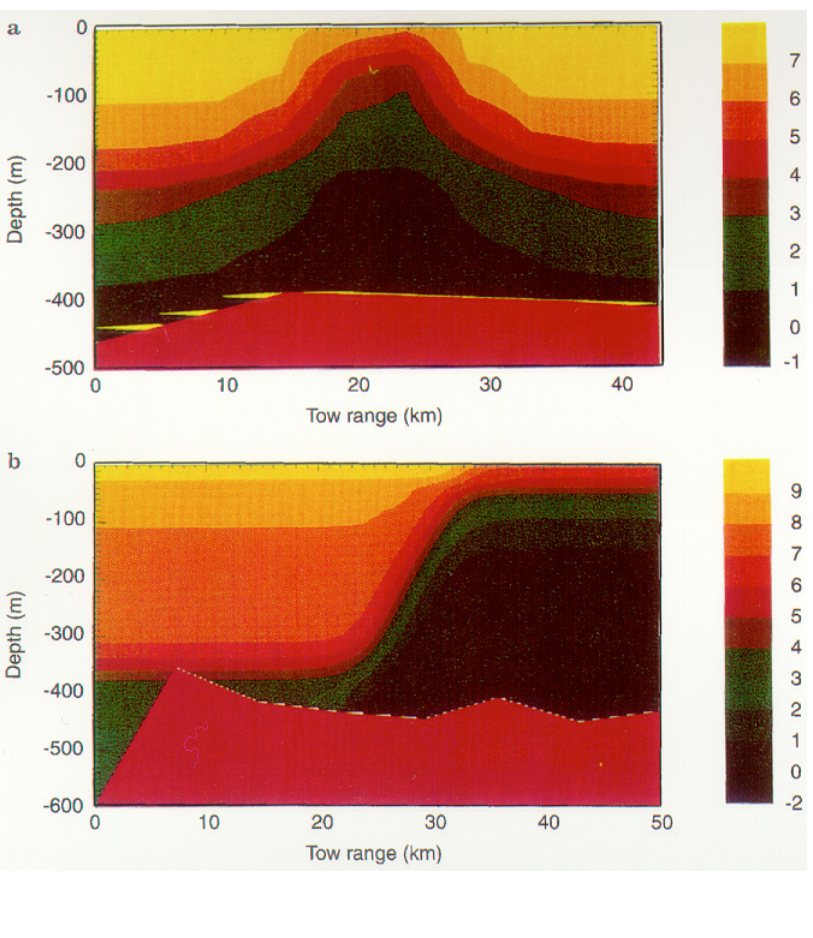
Fig. 6. Temperature-salinity (TS) diagram for the frontal environment, obtained from four CTD sensors on the thermistor chain. Indicated on the dia- gram are the approximations to the TS relationship used for the frontal models ( solid line for cold side and dashed line for the warm side), and also the approxi- mation used for the eddy models ( dotted